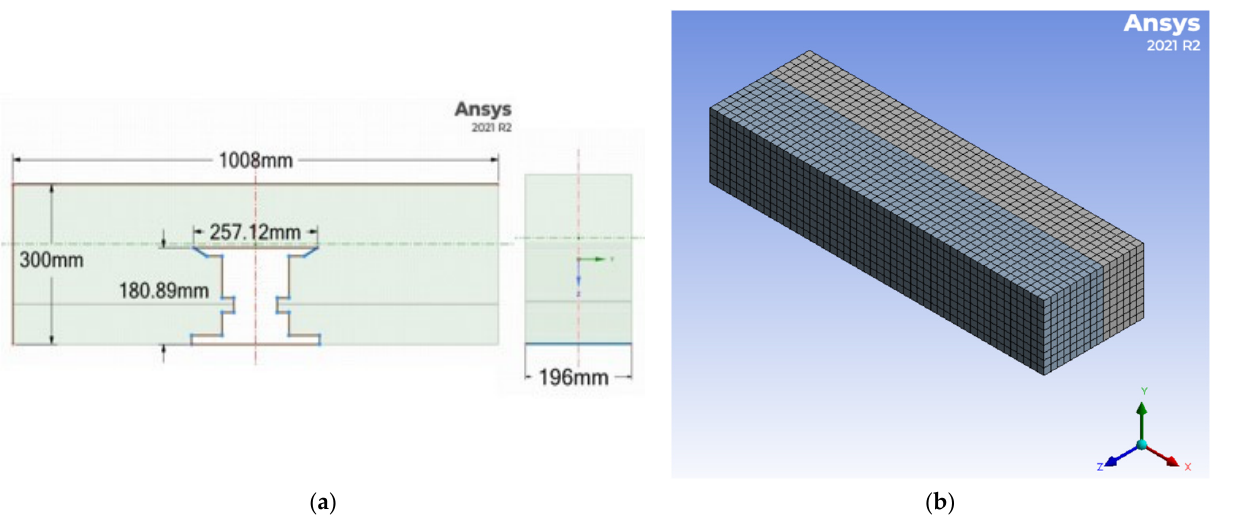
Figure 2. Schematic diagram showing: ( a ) Dimensions of rectangular tank with imperforate baffle; ( b ) Generated mesh of rectangular tank.